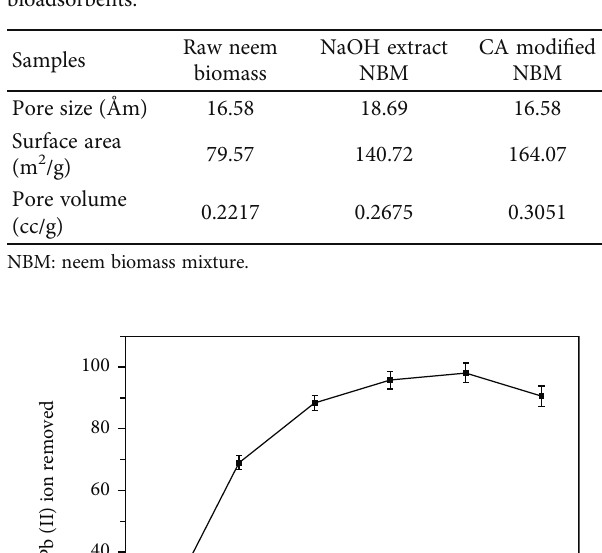
Figure 6: XRD pro fi le of raw neem leaf (RNL), raw neem bark (RNB), and chemically modi fi ed neem biomass (CMNB). Table 7: Results of pore size, BET, and pore volume of bioadsorbents.